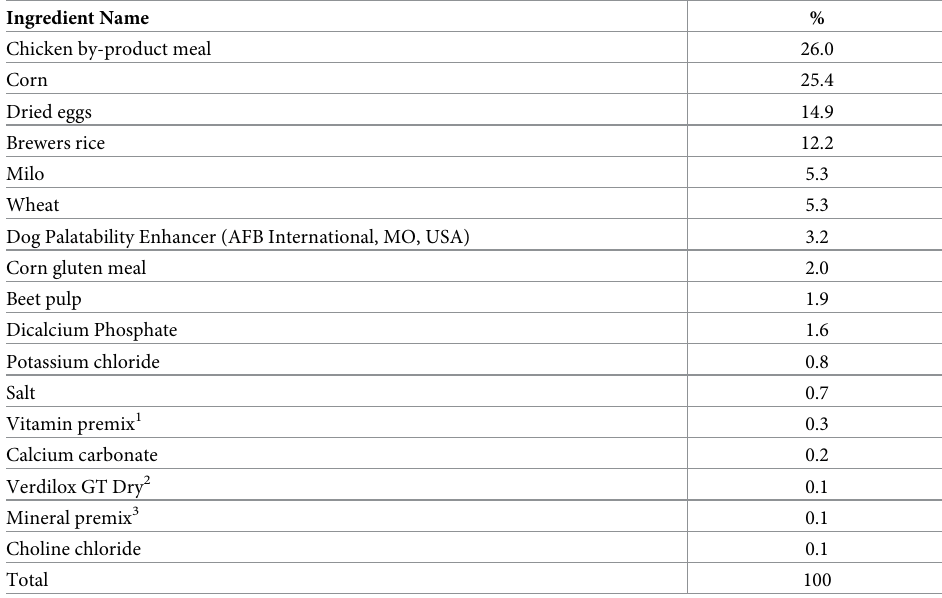
Table 1. Composition of Base Kibble (on as is basis).